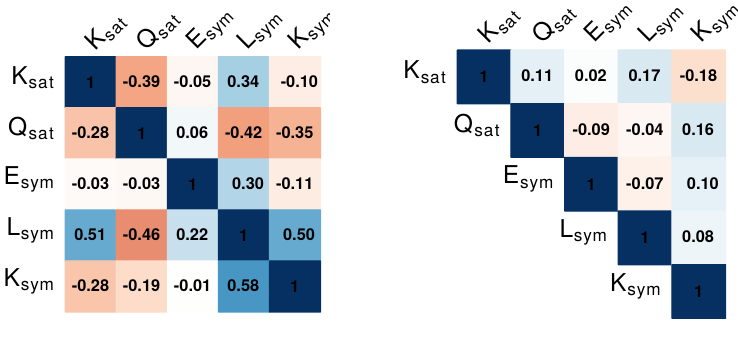
Figure 3. Left panel: Correlations between parameters for P ( µ ) (bottom triangle) and P ( (cid:101) ) (upper triangle) crust matching procedures. Right panel: Correlation difference from the crust matching procedures.